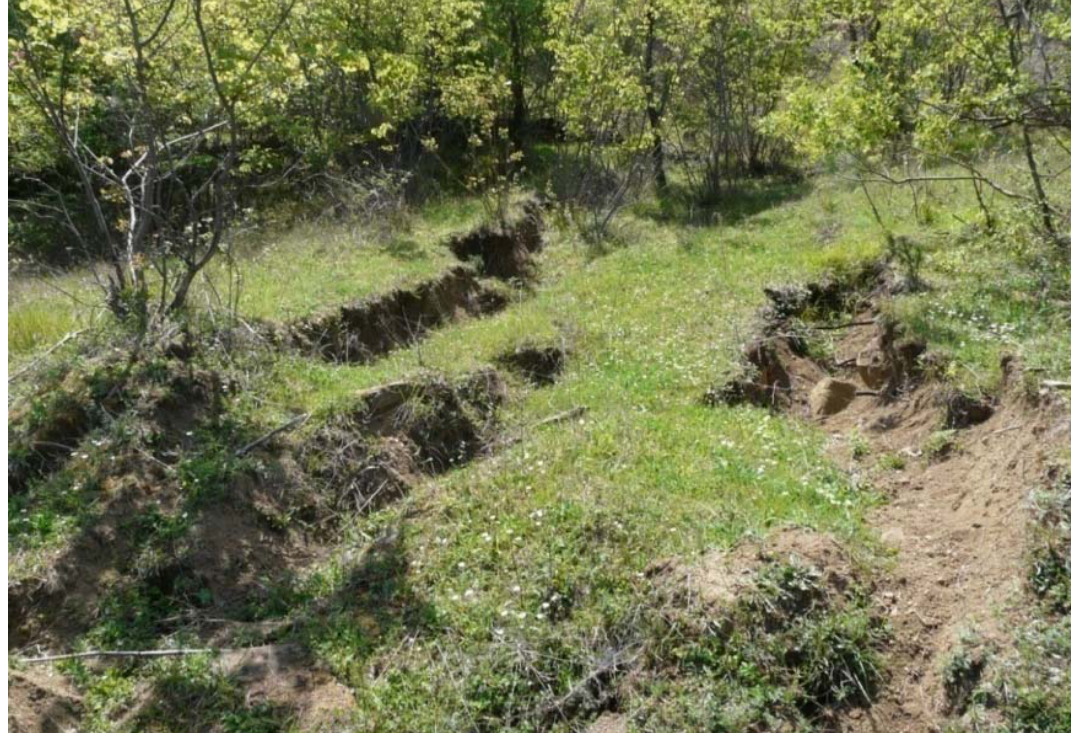
Figure 21. The activity of ALS ‐ 60B is manifested by large horizontal and vertical displacements (here some recent tensional cracks) within its mass.